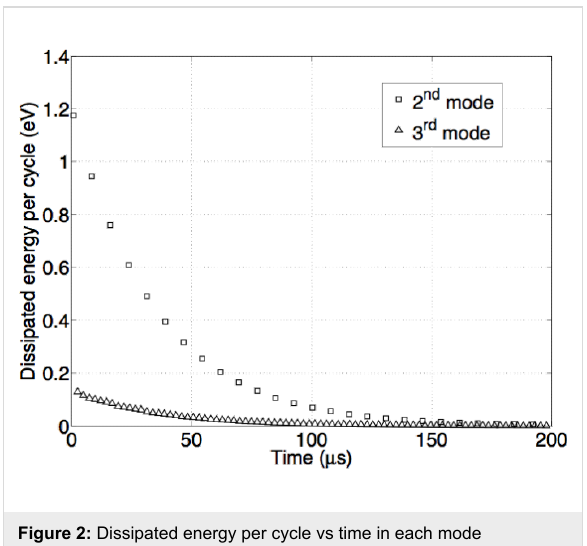
Figure 2: Dissipated energy per cycle vs time in each mode contributing to the dynamics described in Figure